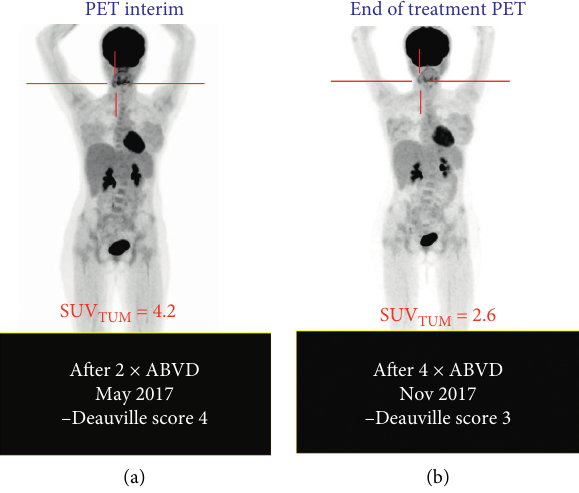
Figure 1: Clinical course of the patient after front-line treatment showing (a) PET-interim partial remission after induction ABVD chemotherapy; (b) PET/CT after completion of 6 cycles reveals complete remission and clinical improvement.